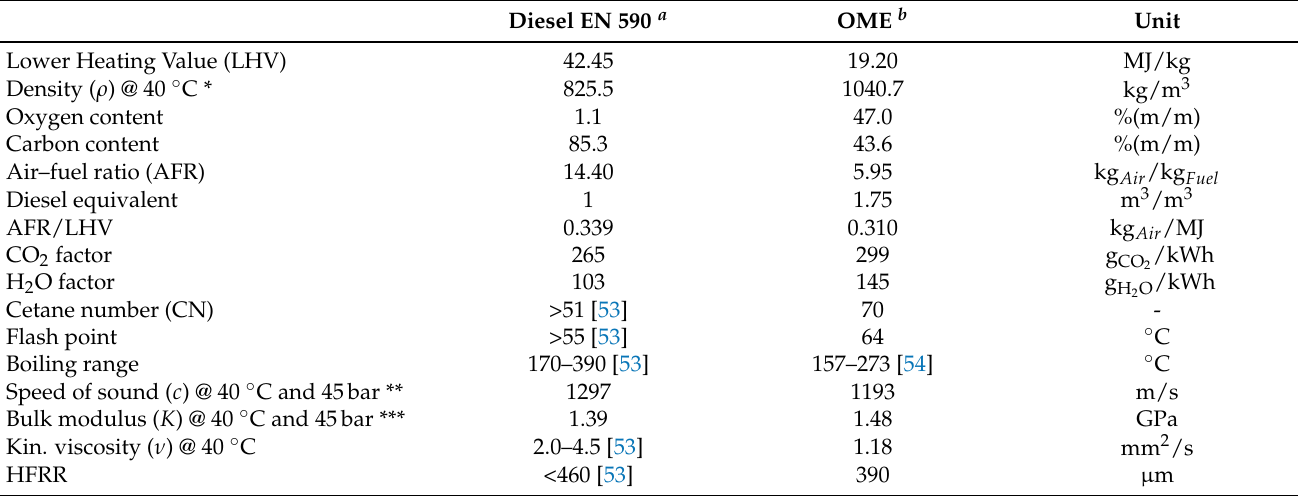
Table 1. Selected fuel properties of diesel according to EN 590 and the test fuel OME-Mix 3–6 used for this